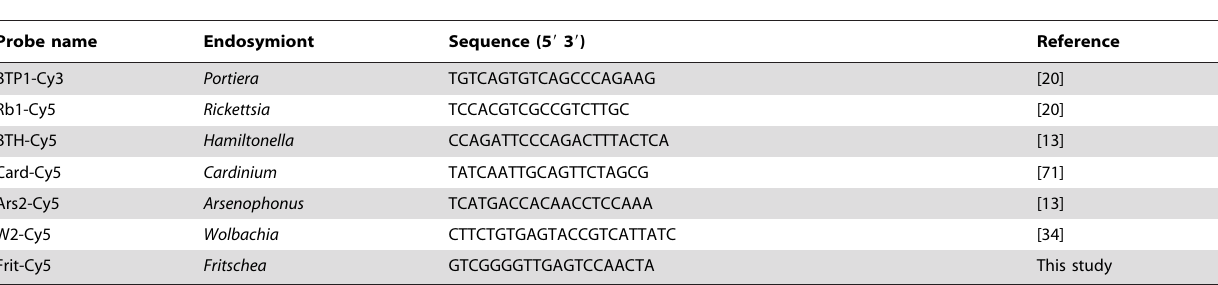
Table 3. Probes used for endosymbiont localization in